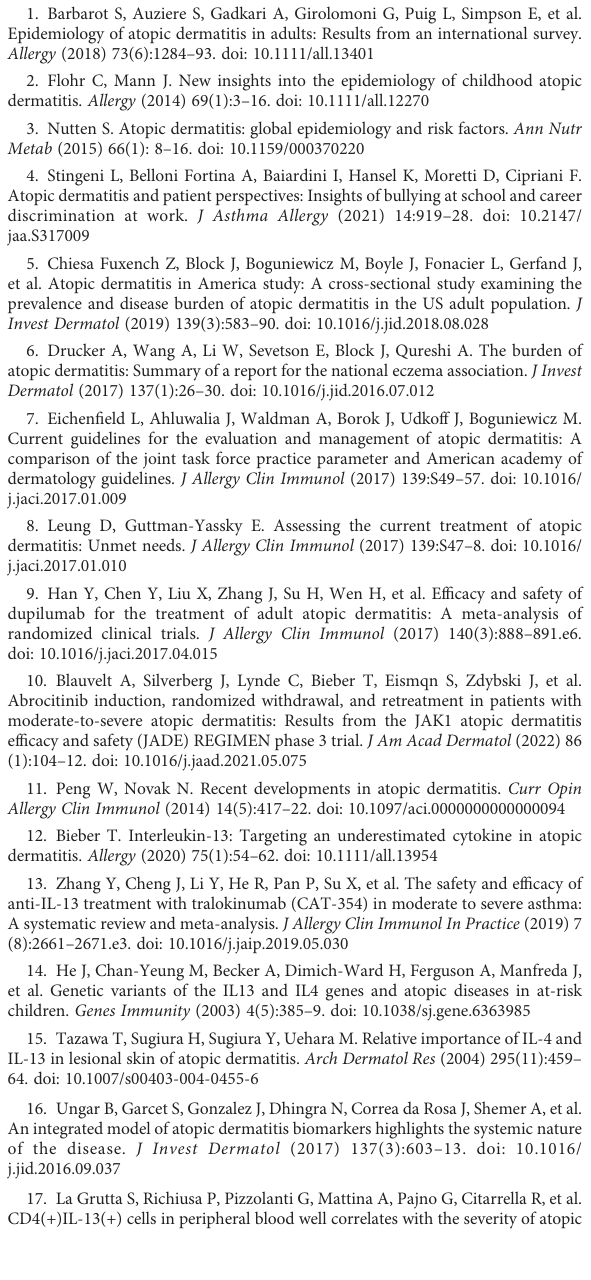
SUPPLEMENTARY FIGURE 3 Forest plot for proportion of patients achieving PGA response at the end of antagonizing IL-13